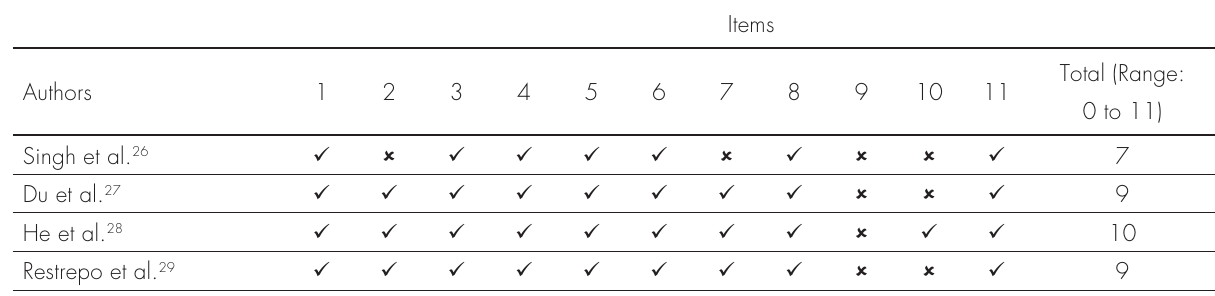
Table I. Critical Appraisal Skills Program quality assessment of the included